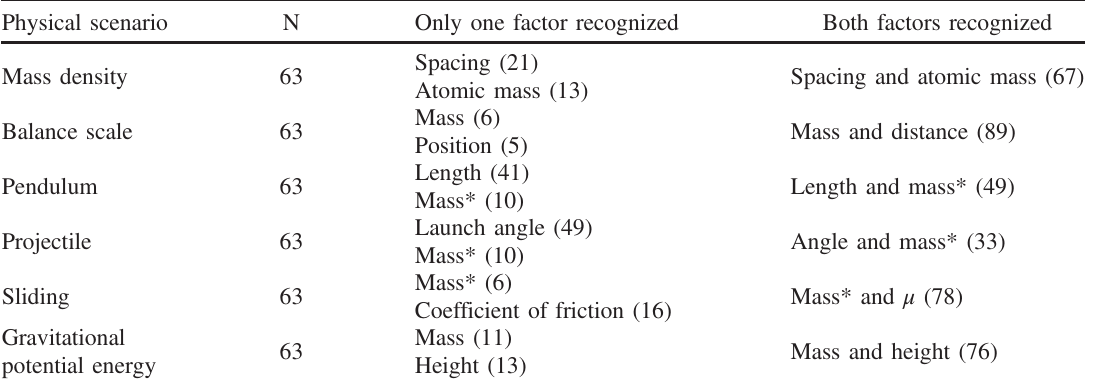
TABLE IX. Experiment 3 recognize condition results. Percentages of participants that recognize that various given factors or combinations of factors can explain given outcomes are in parentheses. Note that the factors with asterisks are not physically correct.